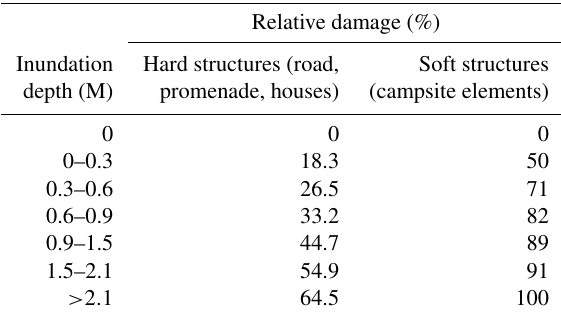
Table 2. Flood-damage curves to obtain relative damage to struc- tures using simulated inundation depth as input (Catalan Water Agency, ACA,